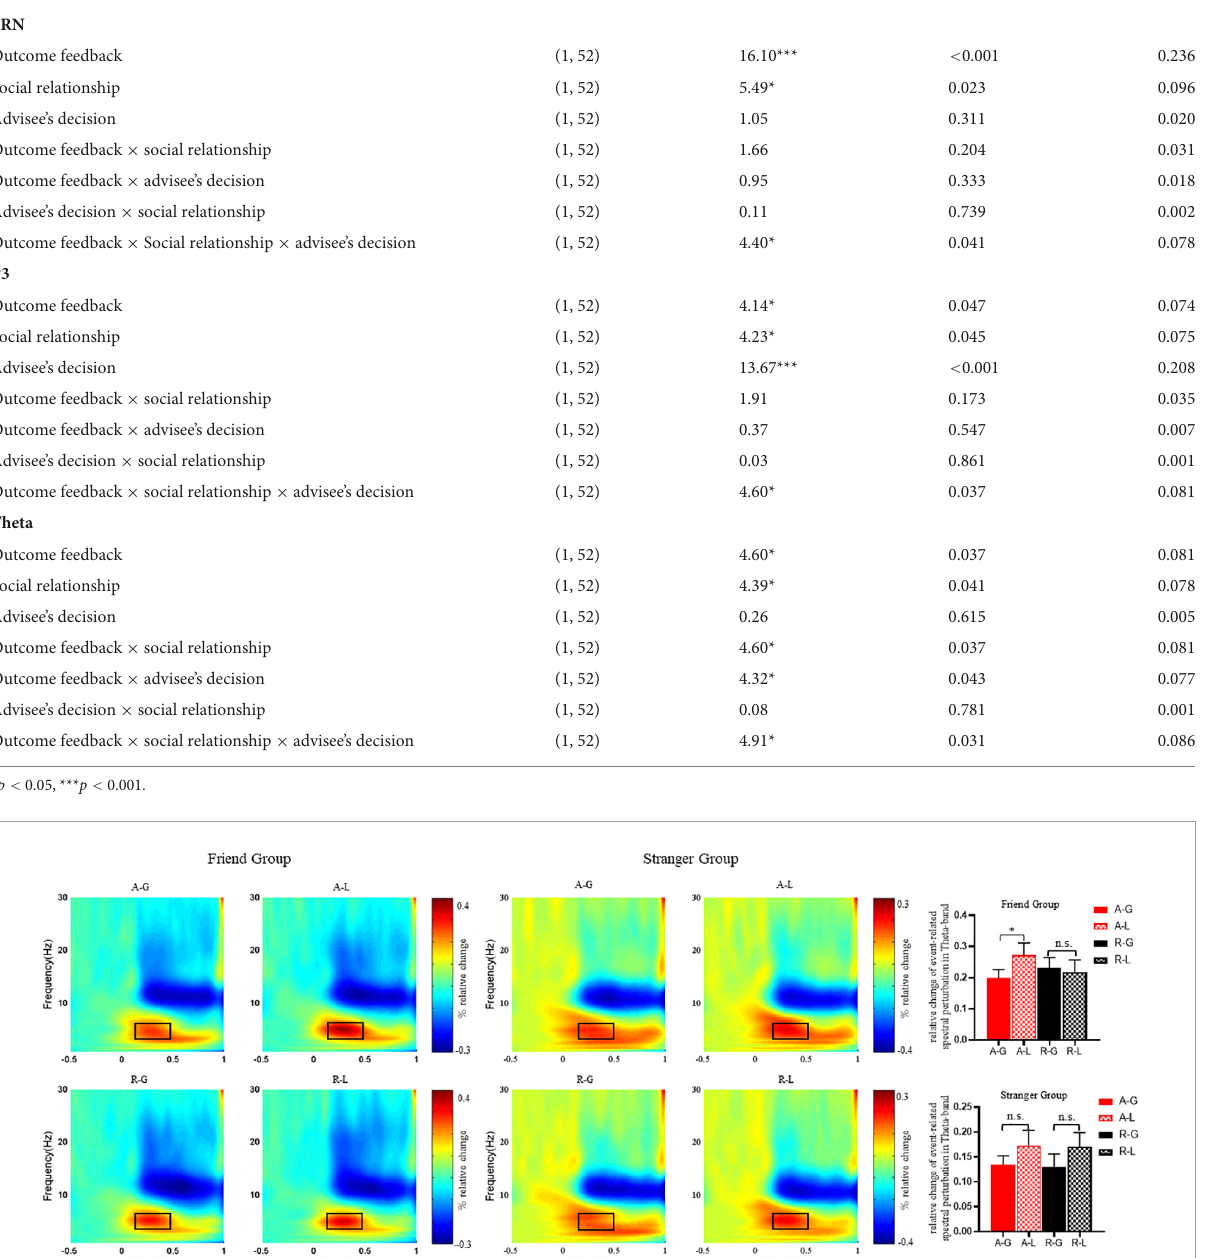
absent in the “stranger-advice acceptance” condition, suggesting that unfamiliar relationship enhanced neural sensitivity to outcomes resulting from social rejection. These results were